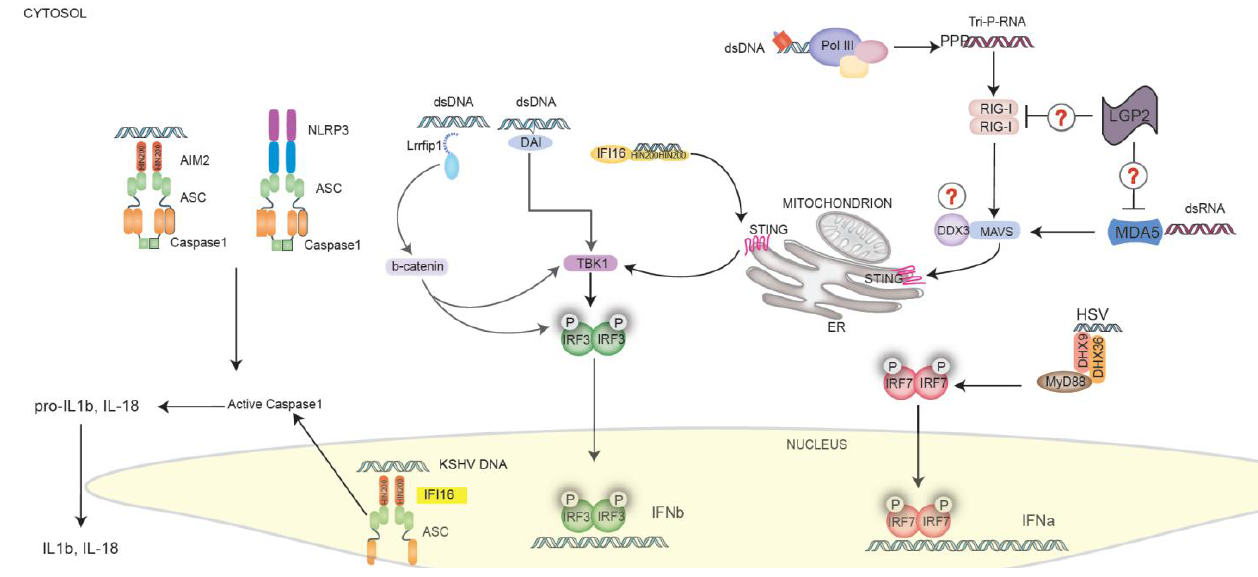
Figure 2. Cytosolic and Nuclear Pattern Recognition Receptors (PRRs). A multitude